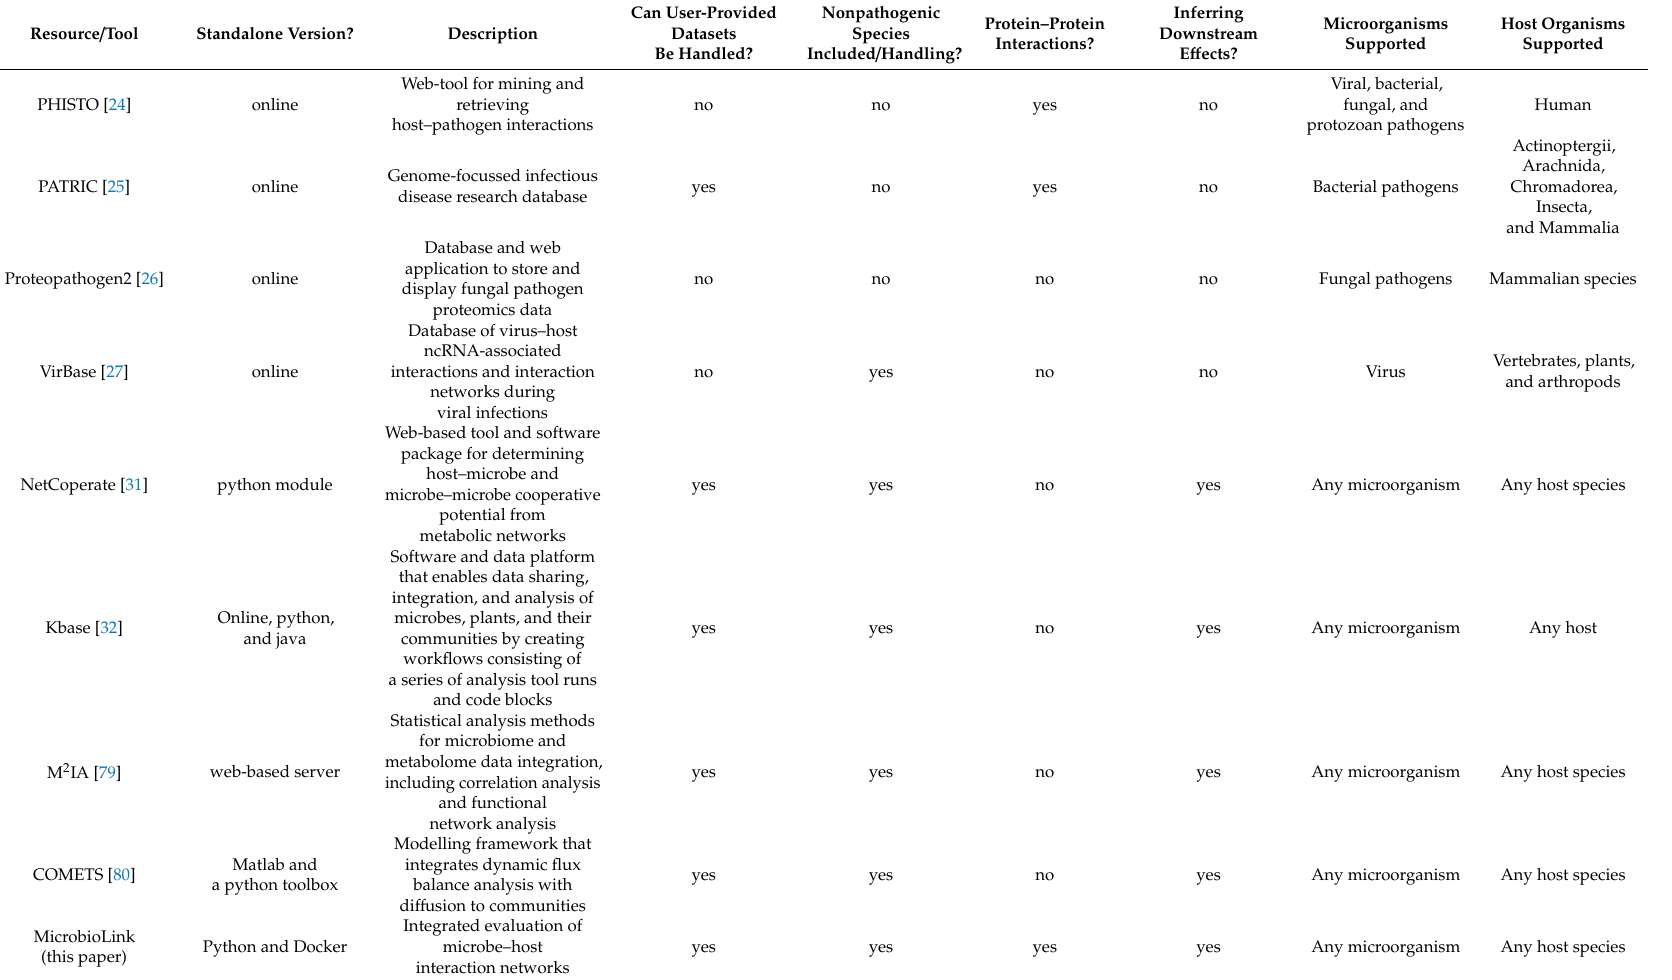
Table 1. Summary of selected tools and resources used in microbe–host interaction